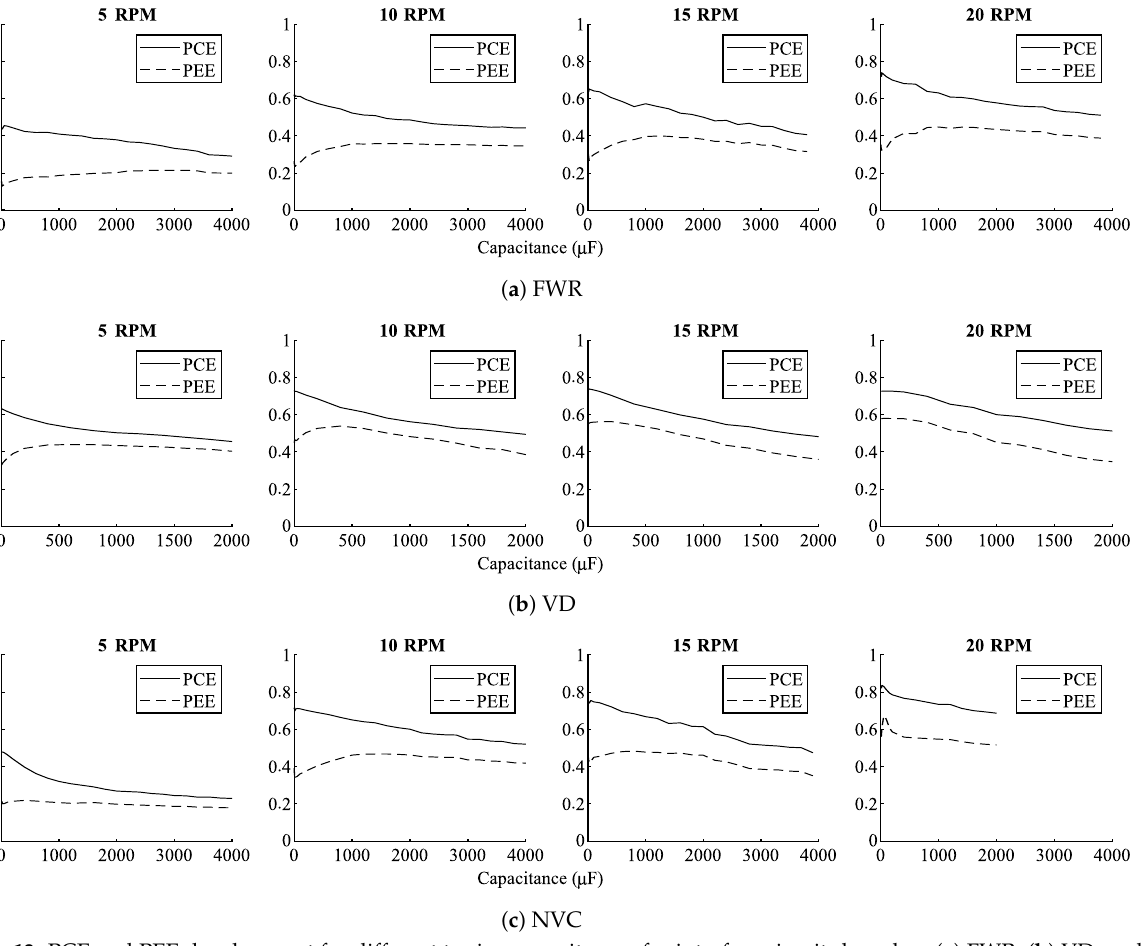
Figure 13. PCE and PEE development for different tuning capacitances for interface circuits based on ( a ) FWR, ( b ) VD, and ( c ) NVC, at the rotational speeds of 5rpm, 10rpm, 15rpm, and